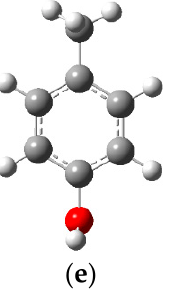
Figure 1. ( a ) AC, ( b ) AC-OH, ( c ) AC-COOH, ( d ) AC-CHO, and ( e ) p -cresol optimized structures.